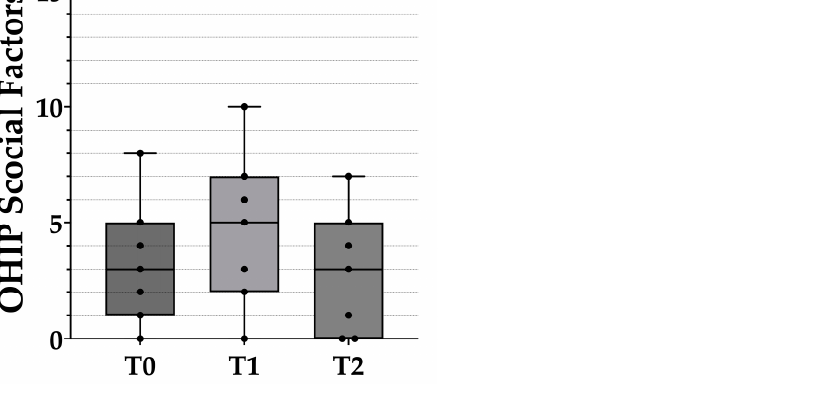
Figure 6. Box plots of the social impact scores from the OHIP-EDENT-J questionnaire. The black dots represent the distribution of raw data. T0: before the clinical remount. T1: immediately after the clinical remount. T2: 1 week after the clinical remount. Statistical analysis was performed with the Wilcoxon sign-rank test. Predetermined level of significance: p <